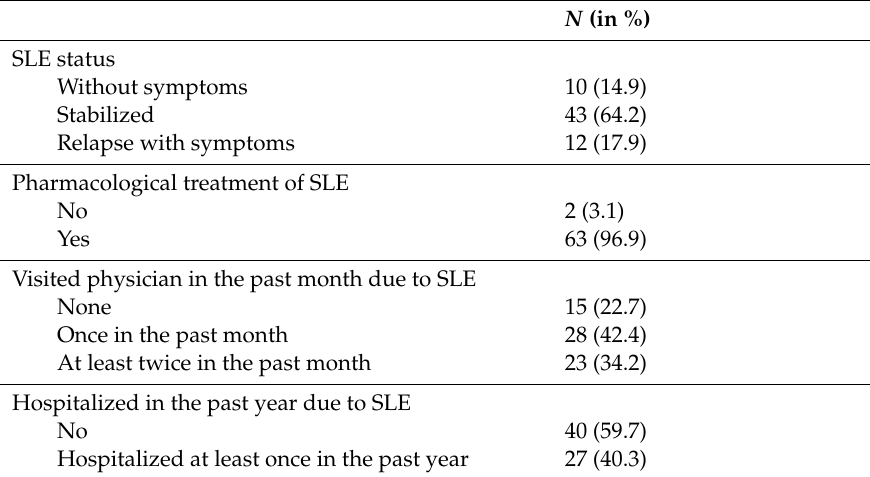
Table 3. Health status and health care utilization (Slovakia 2012–2016, n = 67,